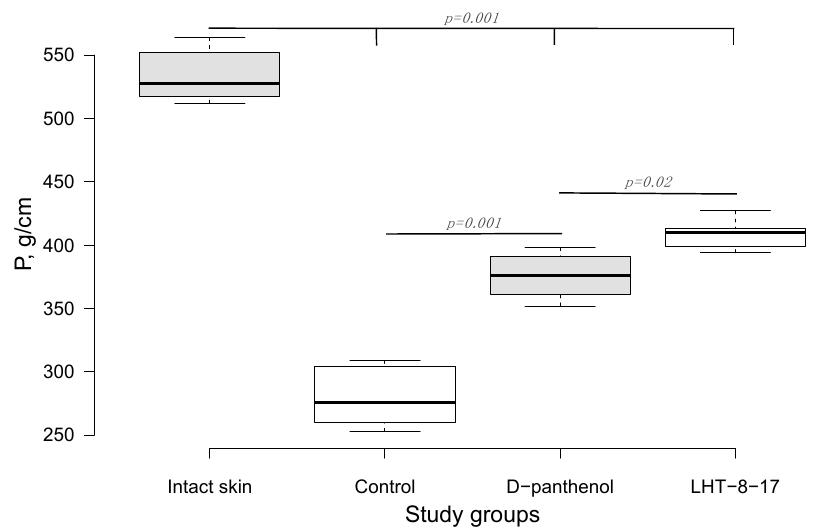
Figure 2. Quantitative evaluation of the skin linear scar firmness in diabetic rats (n = 6 in each group). P (g/cm)—the power needed to rupture the formed scar, presented as the median ± SD. Significant differences were assessed by ANOVA and Tukey tests.